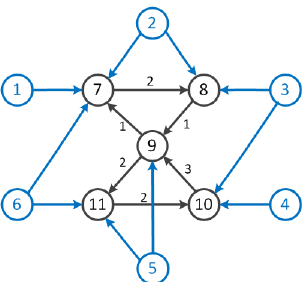
Figure 1. General topology of the agents.